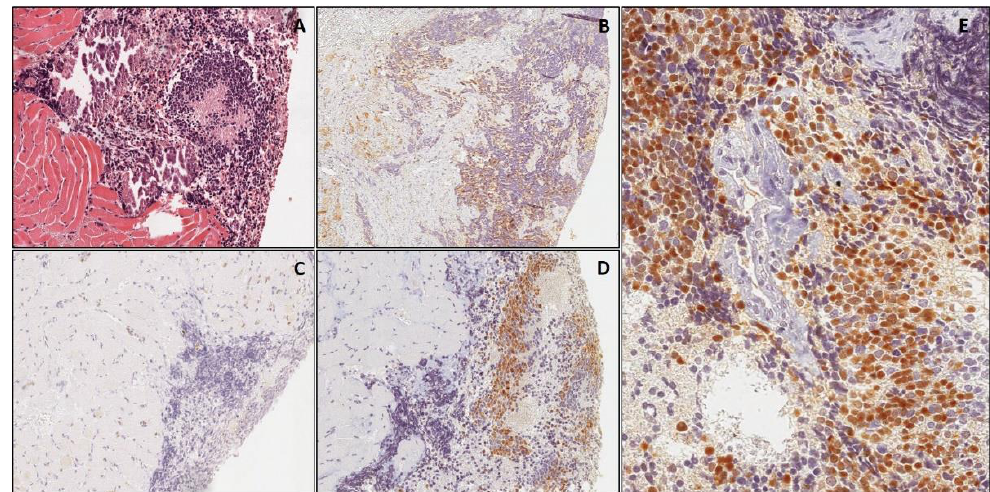
Figure 2. Ewing’s sarcoma, classic type. Serial sections from a small biopsy stained with hematoxy- lin & eosin ( A ). Neoplastic cells are diffusely positive for CD99 ( B ) and negative for WT1 ( C ); endo- thelial cells of intratumoral blood vessels are stained (internal control staining). In ( D , E ) diffuse nu- clear staining for cyclin D1, at low and higher magnification, respectively. ( A – D : original magnifi- cation 40×; E : original magnification 200×).